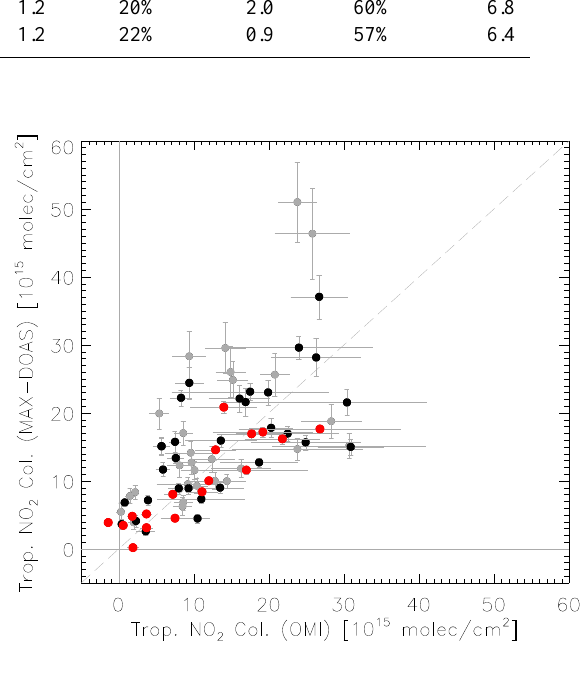
Fig. 15. Comparison between tropospheric NO 2 columns from MAX-DOAS observations in De Bilt and OMI (DOMINO product). The selection of data-points is described in Table 2 (MAX-DOAS), and Sect. 4.4 (OMI), and was applied to all measurements in the observation period (see Sect. 2.2). The selection described in the first row of Table 2 includes all points in the plot, the selection described in the second row includes all black and red points, and the selection of the last row includes only the red points.